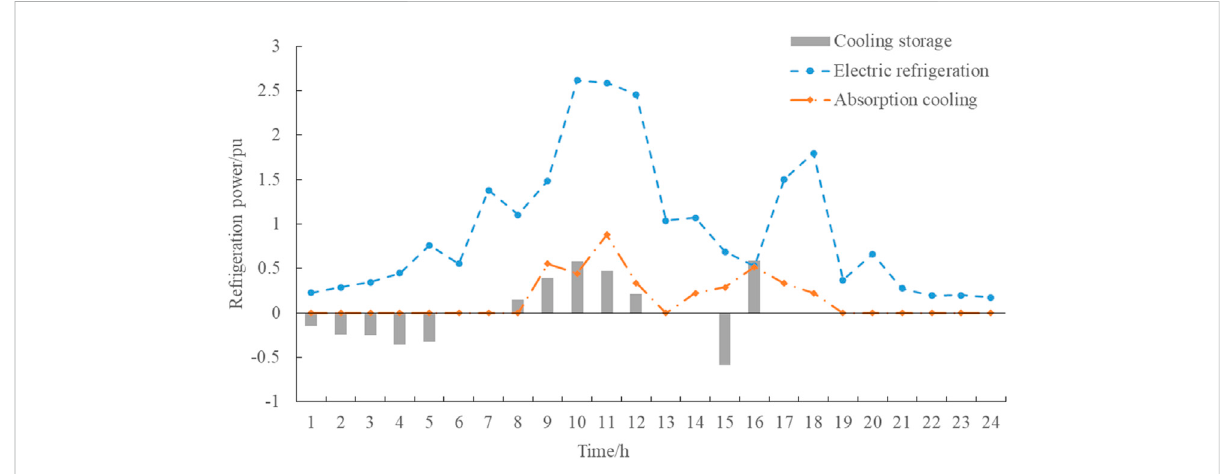
FIGURE 5 Optimization results of cooling output.